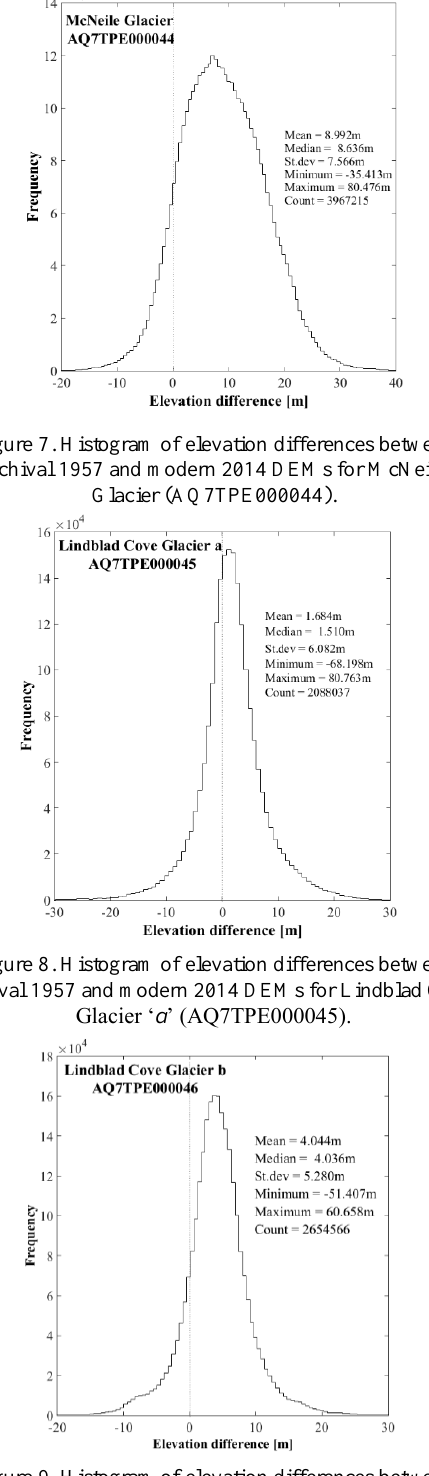
Figure 9. Histogram of elevation differences between archival 1957 and modern 2014 DEMs for Lindblad Cove Glacier ‘ b’